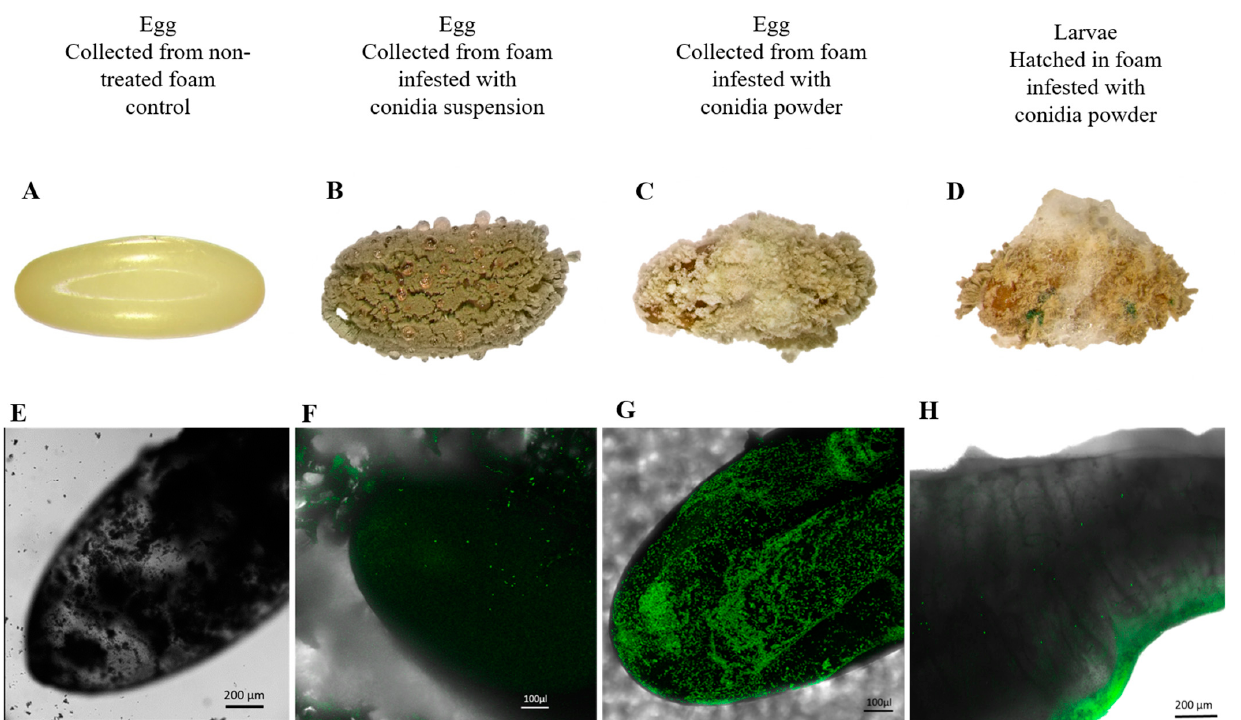
Figure 8. Rhynchophorus ferrugineus eggs and larvae sampled from foam pieces at 5 DPI. Observation for mycosis and sporulation in control egg ( A , E ), egg collected from foam treated with Mb7-GFP conidia suspension (10 8 conidia mL − 1 ) ( B , F ); egg collected from foam treated with Mb7-GFP conidia powder (5 × 10 8 conidia total) ( C , G ) and larvae collected from foam treated with Mb7-GFP conidia powder (5 × 10 8 conidia total) ( D , H ). ( A – D ) Micrographs taken under binocular microscopy follow- ing incubation for sporulation. ( E – H ) Micrographs taken under confocal laser scanning microscopy of eggs and larvae collected from foam pieces. Scale bar = 200 µm.